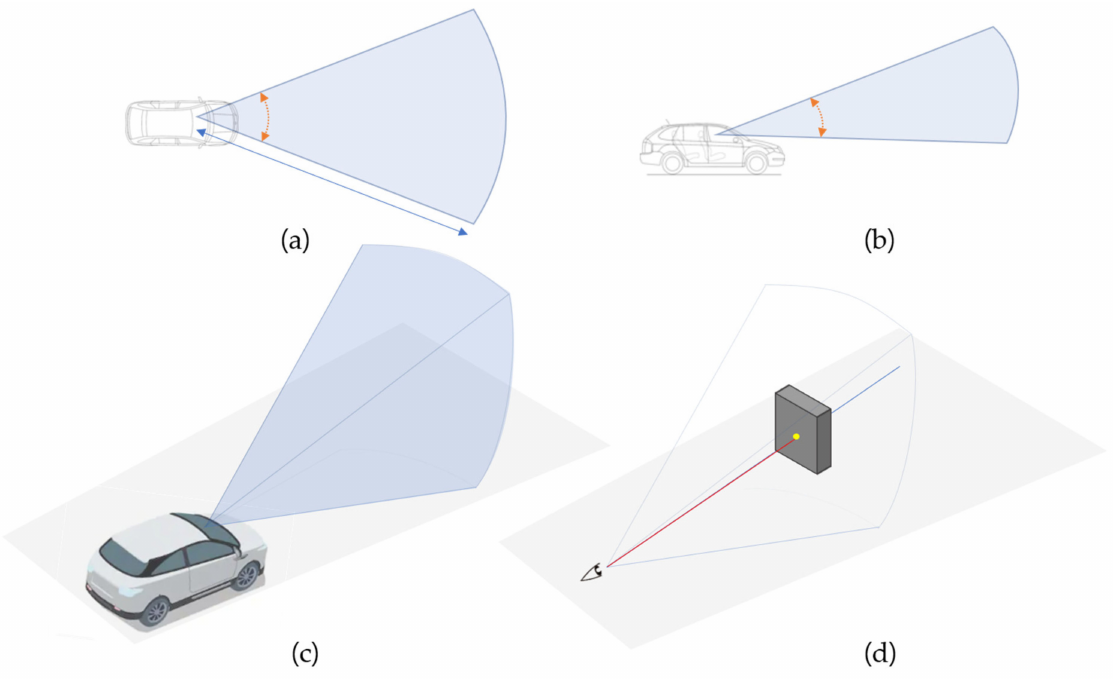
Figure 2. Driver’s visually perceived space. ( a ) Horizontal view of the driver useful field of view (UFOV); ( b ) vertical view of the driver UFOV; ( c ) stereoscopic view of the driver UFOV; ( d ) the line of sight within the driver UFOV.